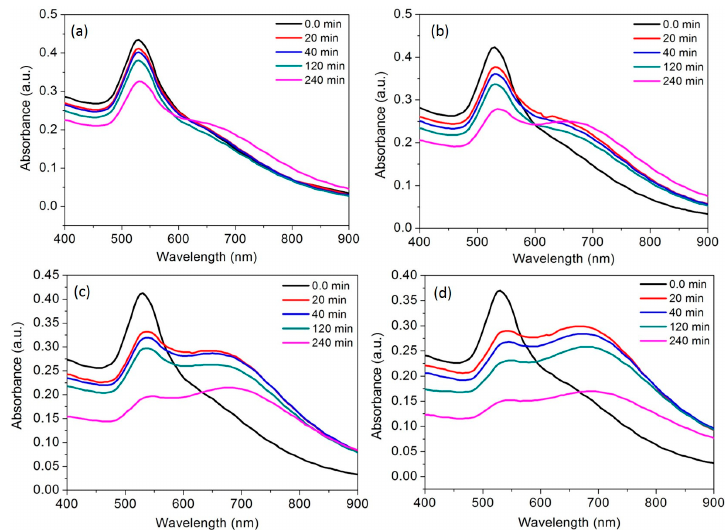
Figure 6. The time course of the spectral response of AuNPs at room temperature; ( a ) in the presence of the Al 3+ (10 ppb); ( b ) in the presence of the Al 3+ (20 ppb), ( c ) in the presence of the Al 3+ (30 ppb); ( d ) in the presence of the Al 3+ (40 ppb).